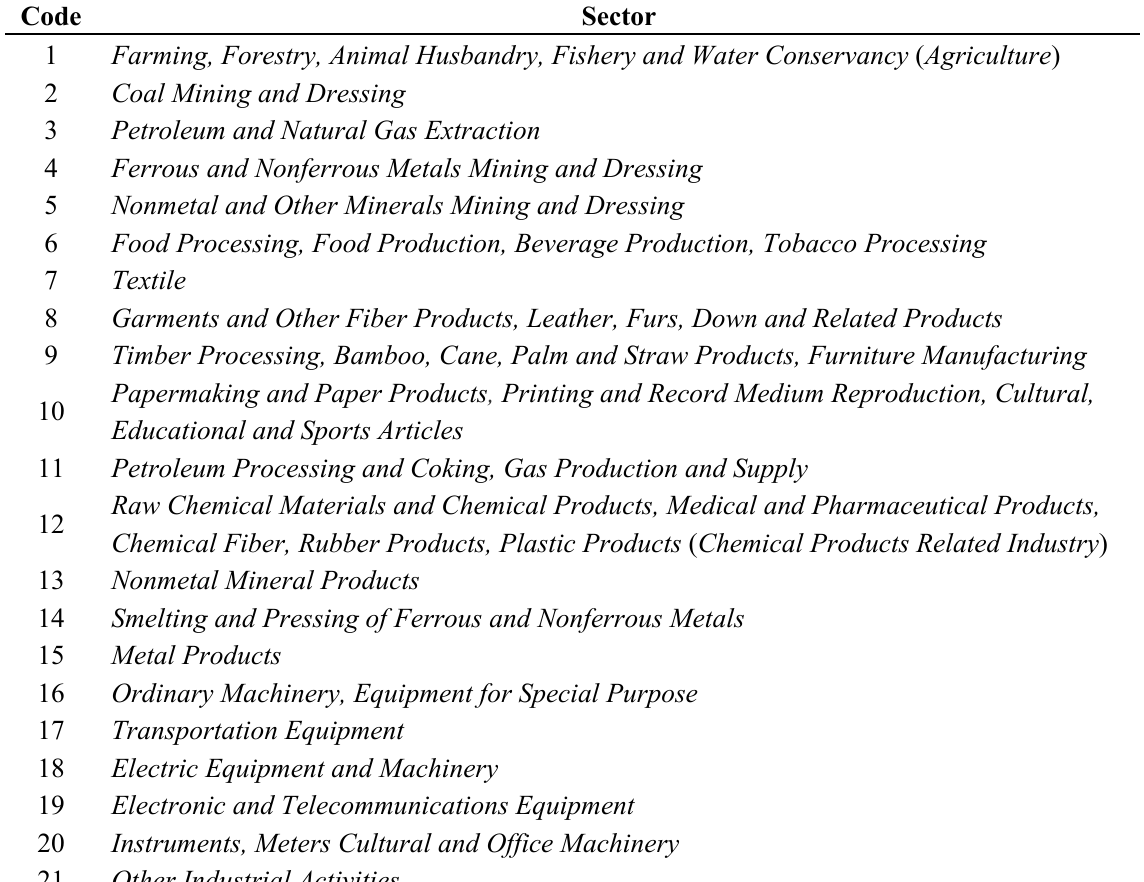
Table 2. Aggregated sectors for input-output